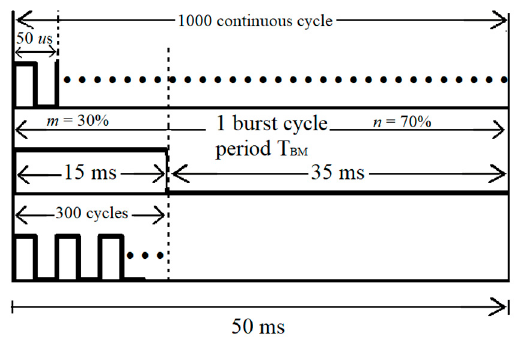
Figure 3. Generation of burst-mode signals by multiplying a continuous 20 kHz signal with one cycle of 20 Hz signal with a conduction period, m , of 30%.